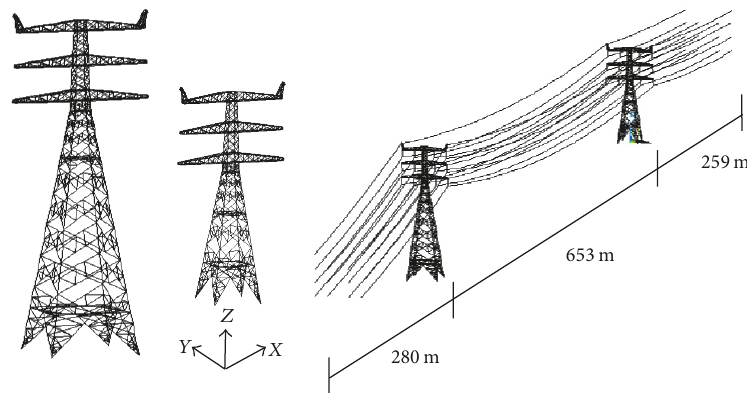
Figure 2: Finite element model of the transmission tower-line